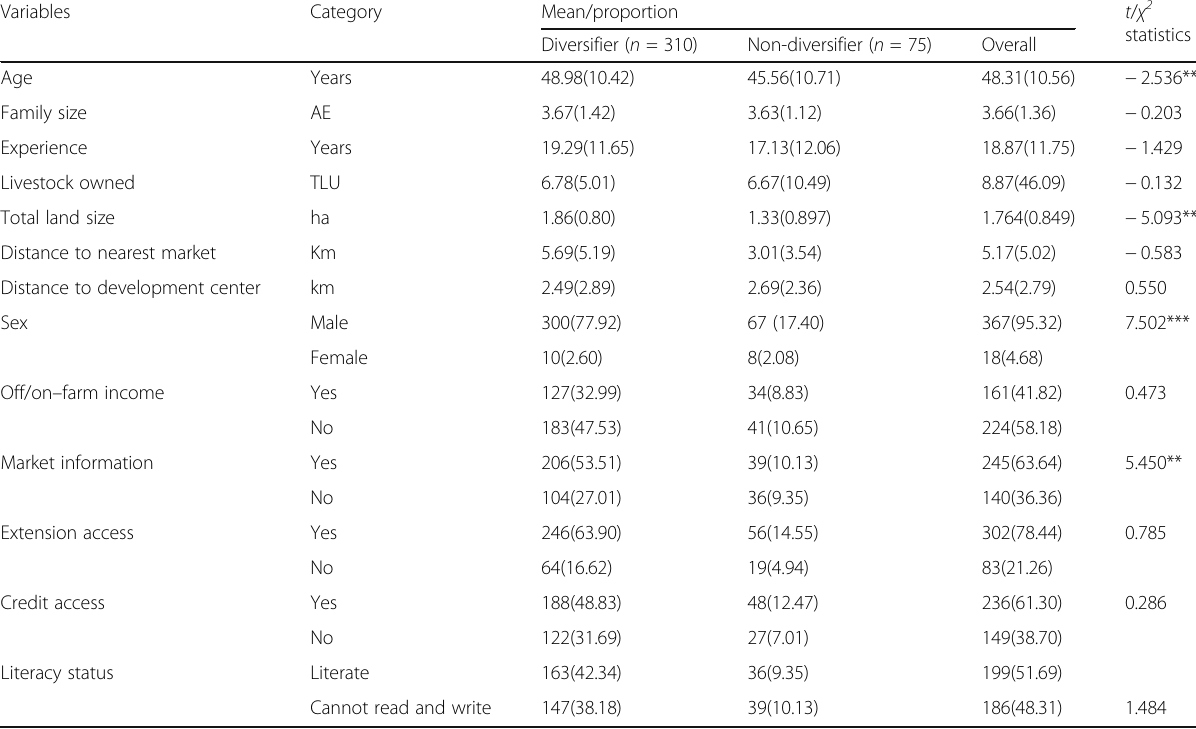
Table 1 Mean and proportion of producers ’ characteristics by crop diversification